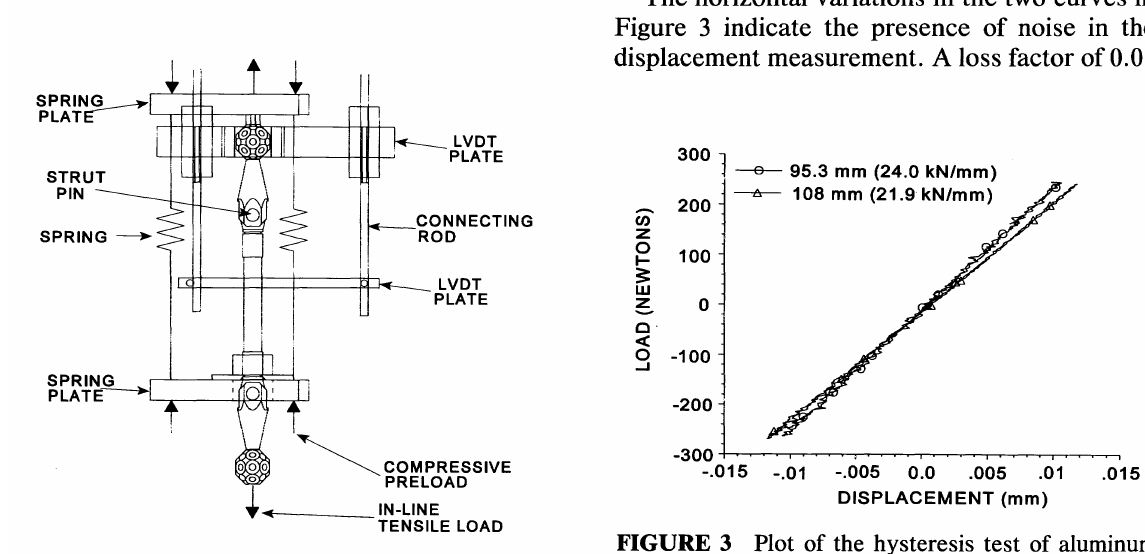
FIGURE 2 Illustration of the test fixture.